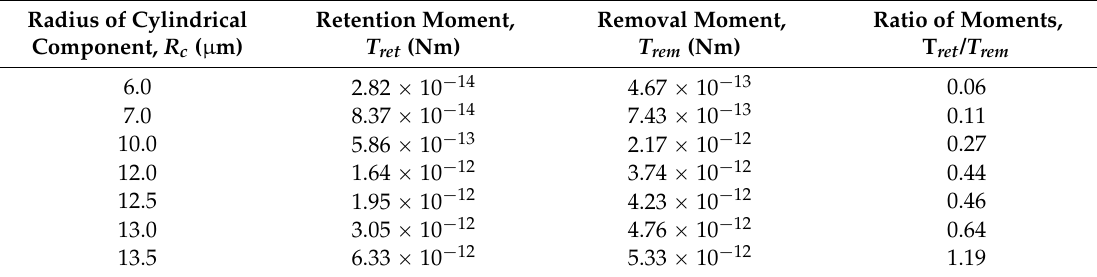
Table 1. Predicted retention moment, removal moment, and moment ratio for cylindrical components of various